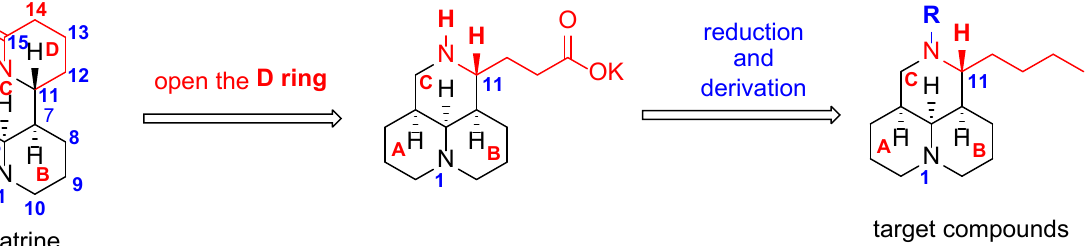
Figure 1. The structure of matrine and target compounds.